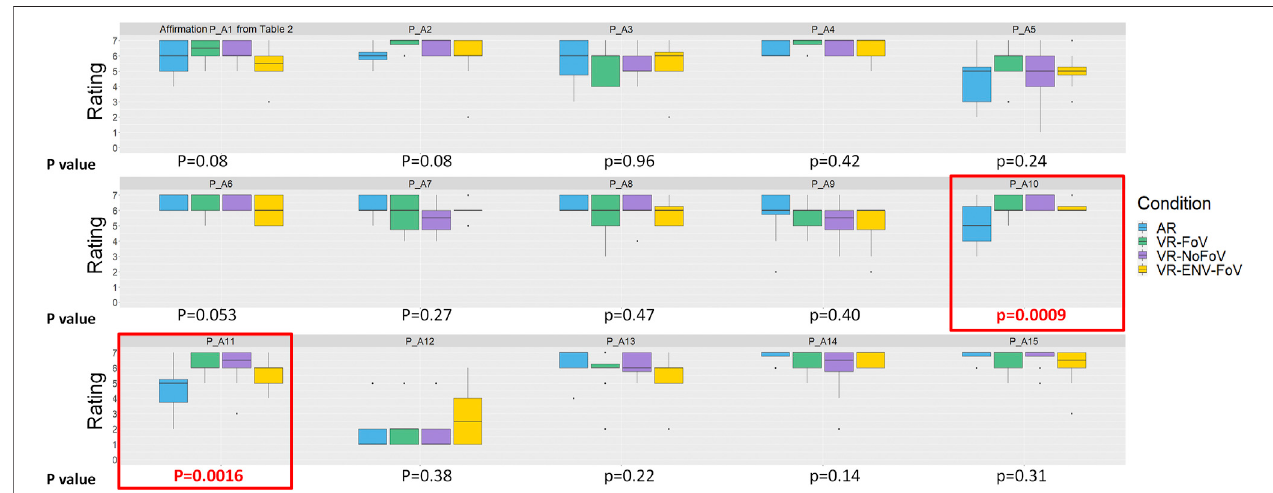
FIGURE 9 | Ratings given to each af fi rmation of Table 2 collected at the end of the statement. p -values for these factors are the result of independent ANOVAs.